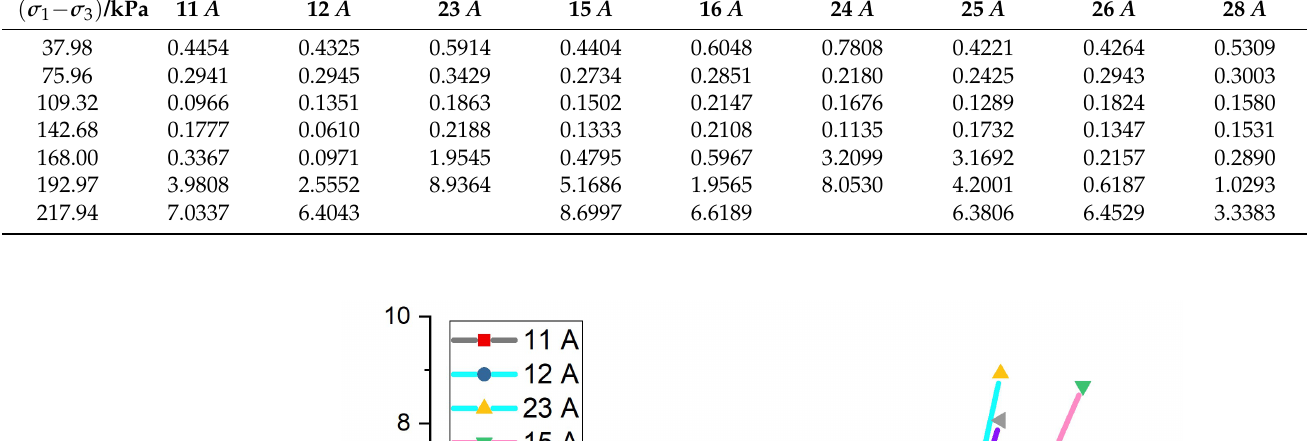
Table 6. The fitting A values of all the specimens under all the ADS levels.